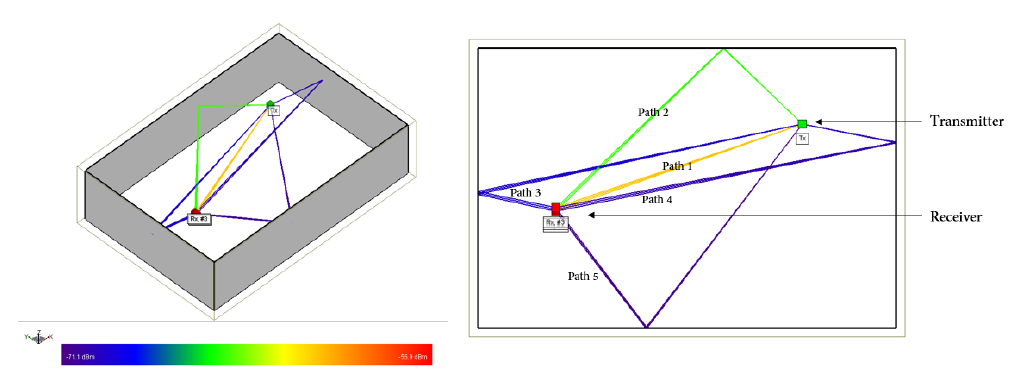
Figure 2. Multipath propagation simulated by the Wireless Insite software.